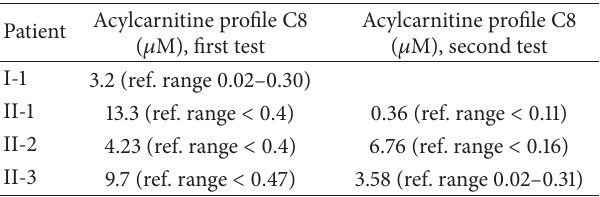
Table 1: Plasma concentration of C8 acylcarnitines in the proband and the three